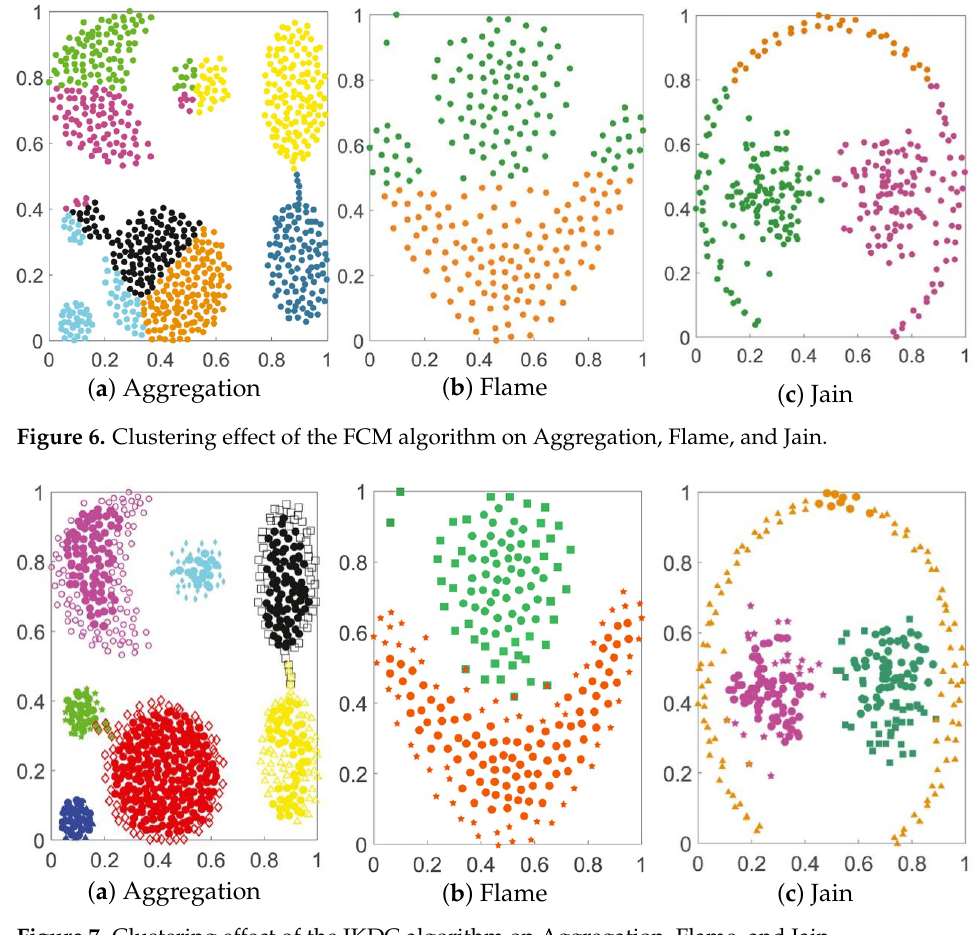
Figure 7. Clustering effect of the IKDC algorithm on Aggregation, Flame, and